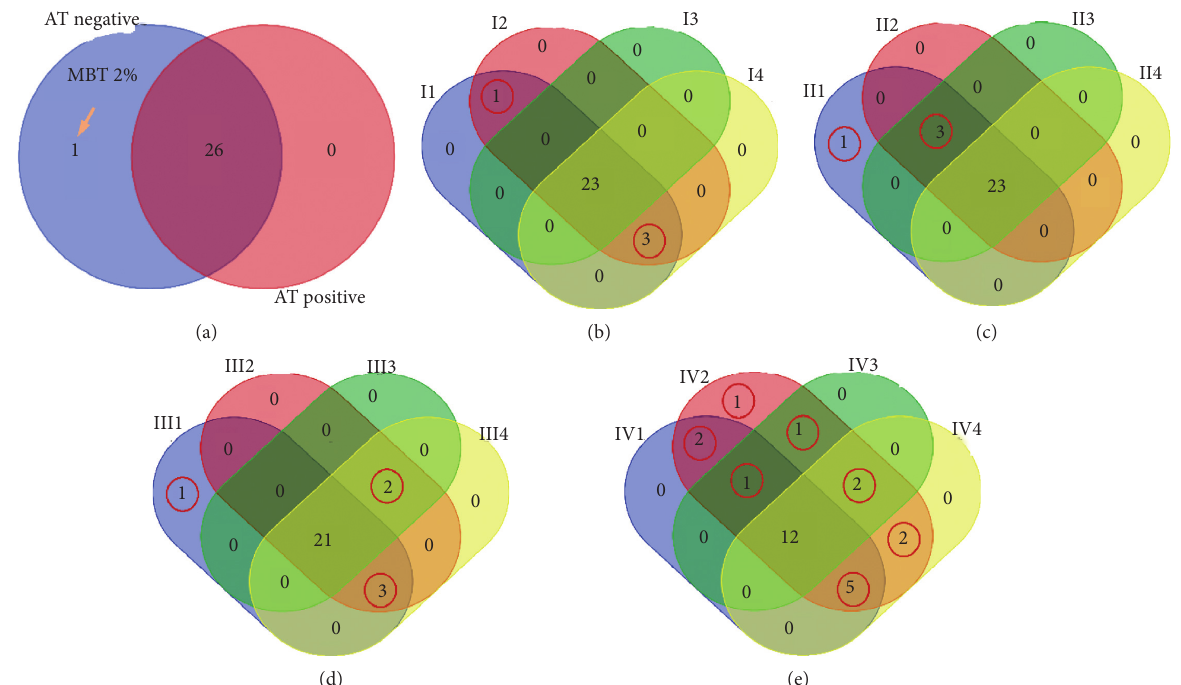
Figure 1: Venn diagrams of AT-negative and AT-positive subpopulations. AT-negative patients were uniquely sensitized by MBT 2% (a). In addition, benzalkonium chloride 0.1%, quinoline mix 6%, and mercapto mix 2% sensitized commonly the AT-negative females, AT-negative males, and AT-positive females, while MBT 2% was common to AT-negative females and AT-negative males (b). Further on, MBT 2% uniquely sensitized AT-negative WhC, while AT-negative BlC, AT-negative WhC, and AT-positive WhC were commonly sensitized by benzalkonium chloride 0.1%, primin 0.01%, and black rubber mix 0.1% (c). The next comparison revealed that AT-negative BlC females, AT-negative WhC females, and AT-negative WhC males were commonly sensitized by primin 0.01%, quinoline mix 6%, and paratertiary butylphenol 1%. At the same time, AT-negative BlC females, AT-negative WhC females, and AT-negative BlC males were commonly sensitized by benzocaine 5% and mercapto mix 2%. Finally, AT-negative WhC males were uniquely sensitized by MBT 2% (d). In the case of AT-positive patients with respect to gender and occupation, more common and unique allergens were found. In particular, finally, epoxy resin 1% uniquely sensitized the AT-positive WhC females, AT-positive BlC males, and AT-positive WhC males. Further on, wool alcohols 30% uniquely sensitized AT-positive WhC females and AT-positive BlC males, while benzalkonium chloride 0.1% uniquely sensitized the AT-positive WhC males. In addition, AT-positive BlC females, AT-positive WhC females, and AT-positive BlC males were commonly sensitized by mercury 0.05% and 5-chloro-2-methyl-4-itz-3. Similarly, AT-positive WhC females and AT-positive WhC males were commonly sensitized by primin 0.01% and black rubber mix 0.1%. AT-positive BlC females and AT-positive WhC females were commonly sensitized by quinoline mix 6% and mercapto mix 2%. Finally, AT-positive BlC females, AT-positive WhC females, and AT-positive WhC males were commonly sensitized by quaternium-15 1%, paraben mix 15%, neomycin sulphate 20%, paratertiary butylphenol 1%, and colophony 20% (e). AT : atopy, WhC: white collars, BlC: blue collars, I1: AT-negative males, I2: AT-negative females, I3: AT-positive males, I4: AT-positive females. II1: AT-negative white collars, II2: AT-negative blue collars, II3: AT-positive white collars, II4: AT-positive blue collars. III1: AT-negative white-collar males, III2: AT-negative white-collar females, III3: AT-negative blue-collar males, III4: AT-negative blue-collars females. IV1: AT-positive white-collar males, IV2: AT-positive white-collar females, IV3: AT-positive blue-collar males, and IV4: AT-positive blue-collar